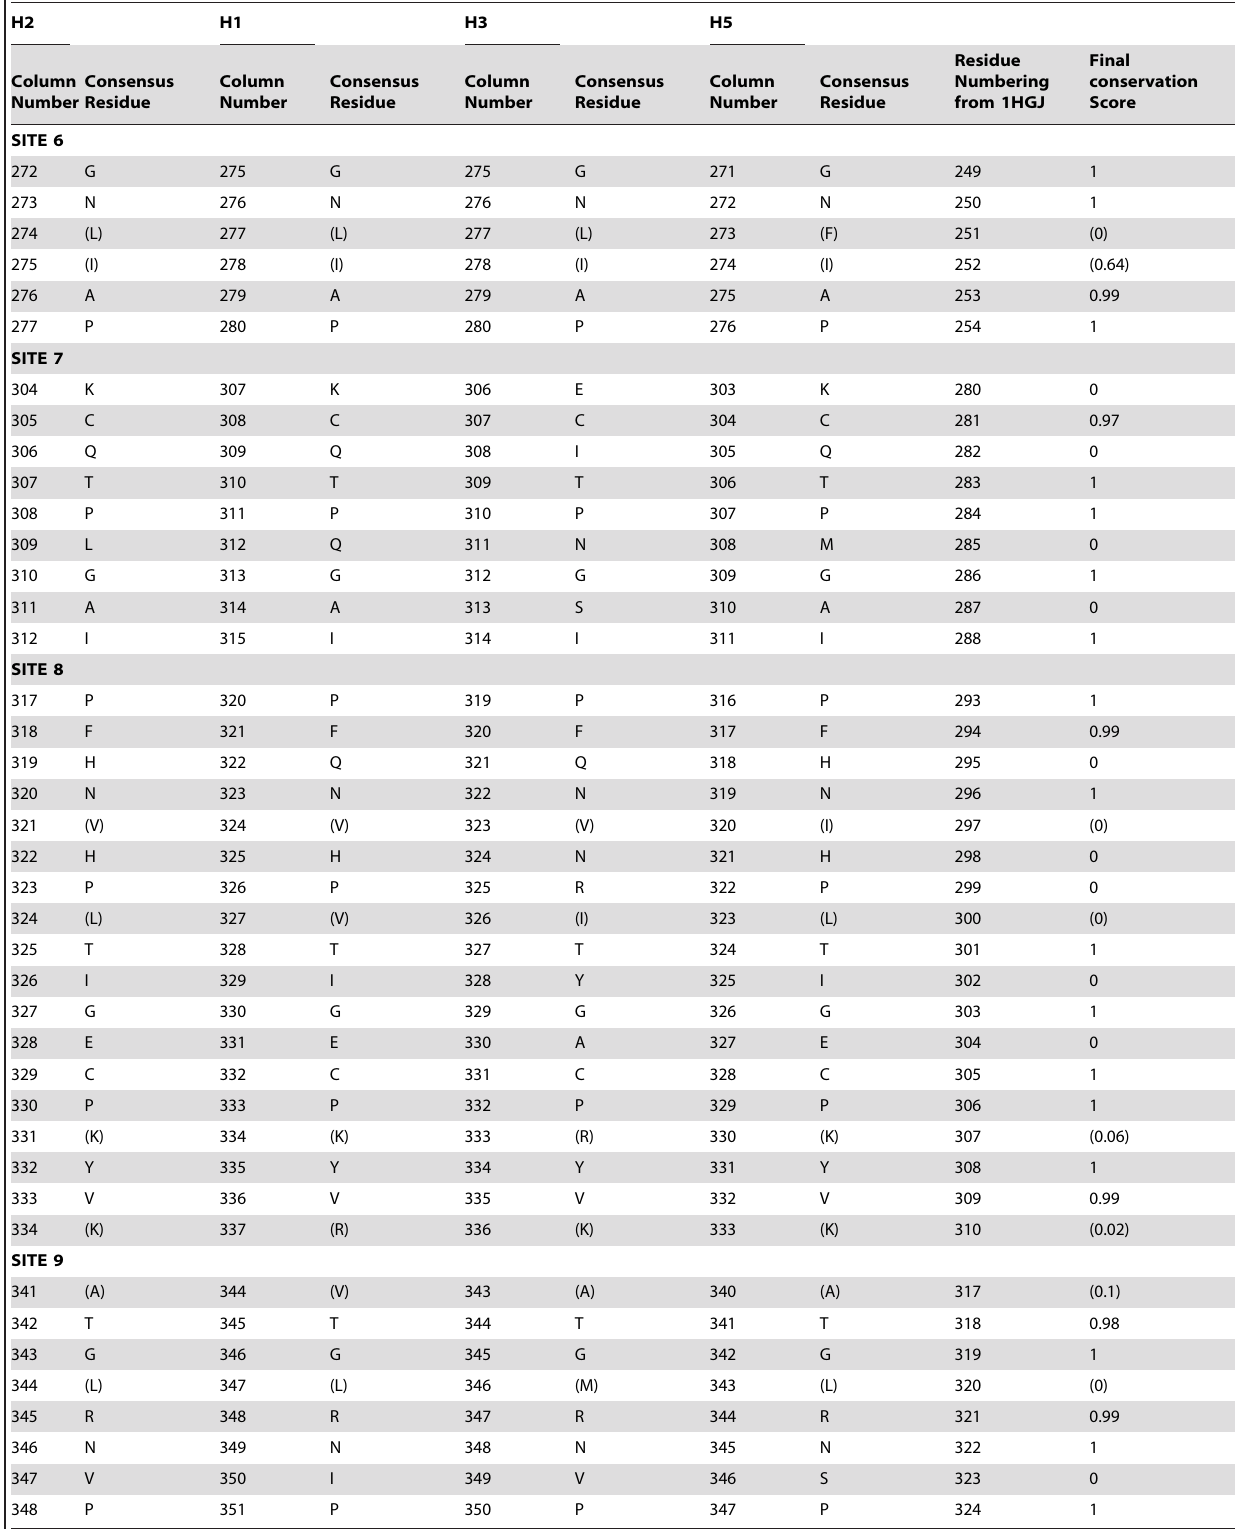
Table 2. Identified Influenza A conserved regions/sites